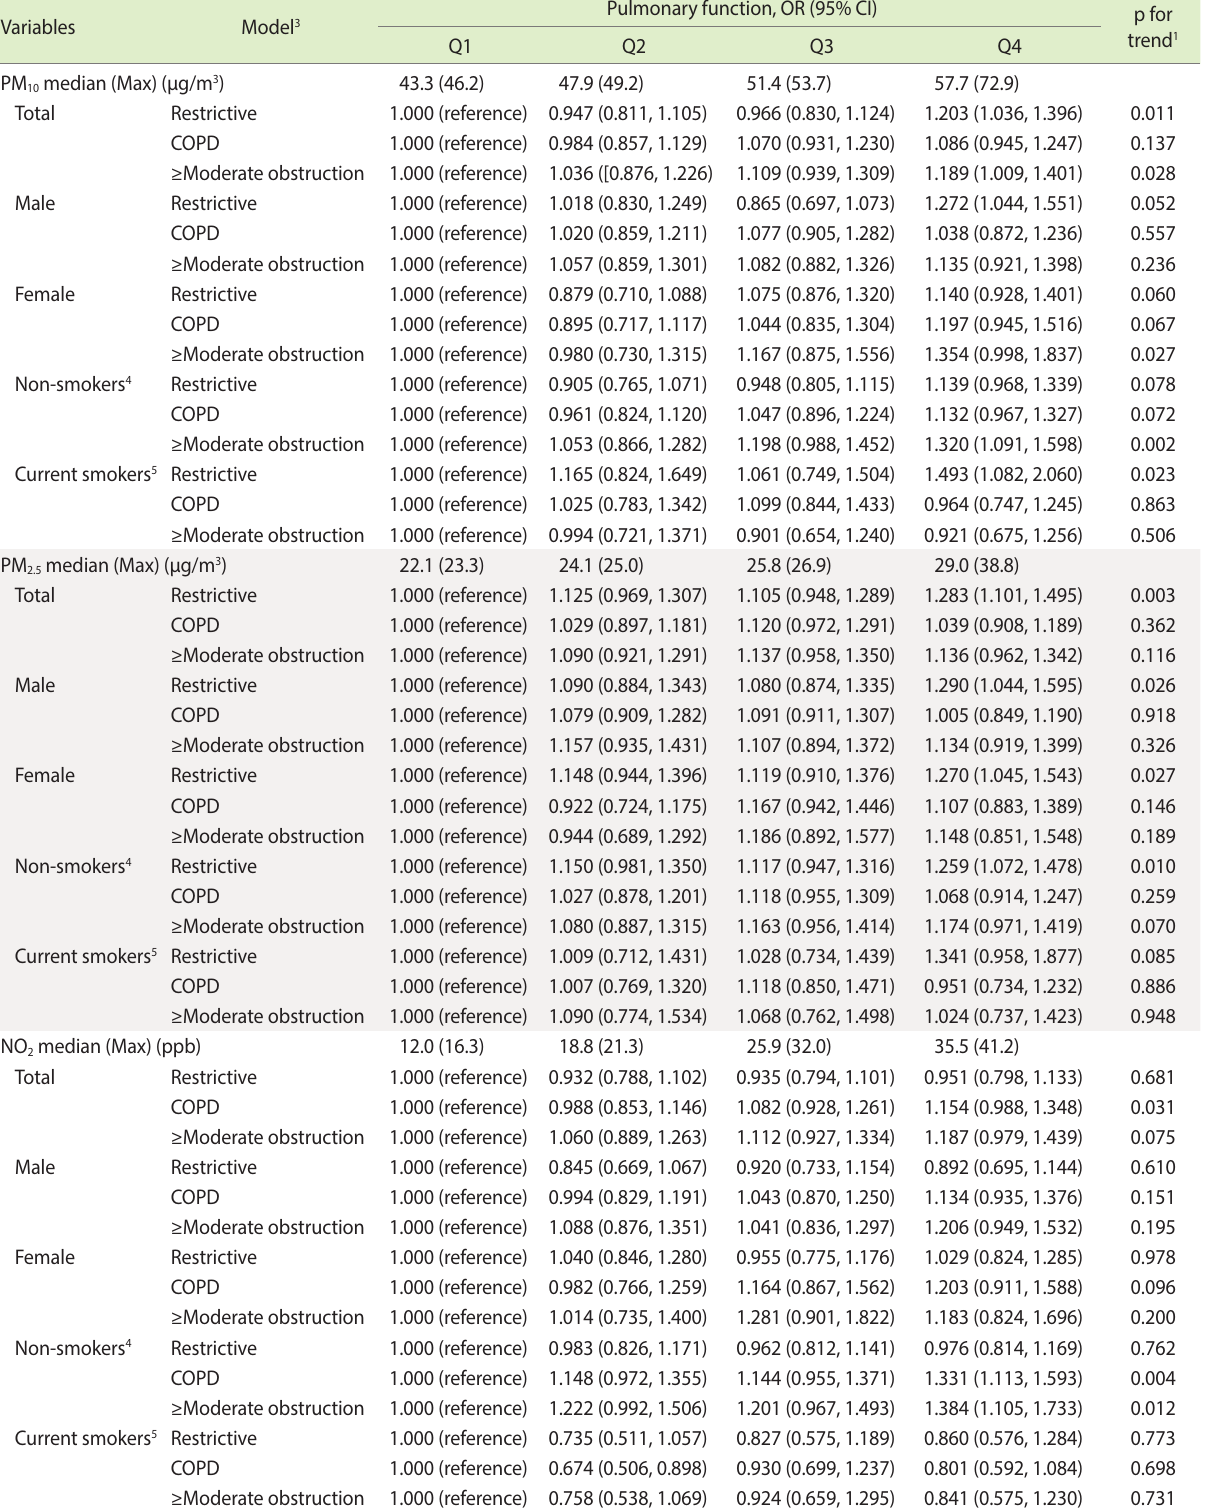
Table 2. ORs for air-pollution variables with a 2-year lag period for pulmonary function 1 using multivariate logistic regression analysis after adjusting for covariates